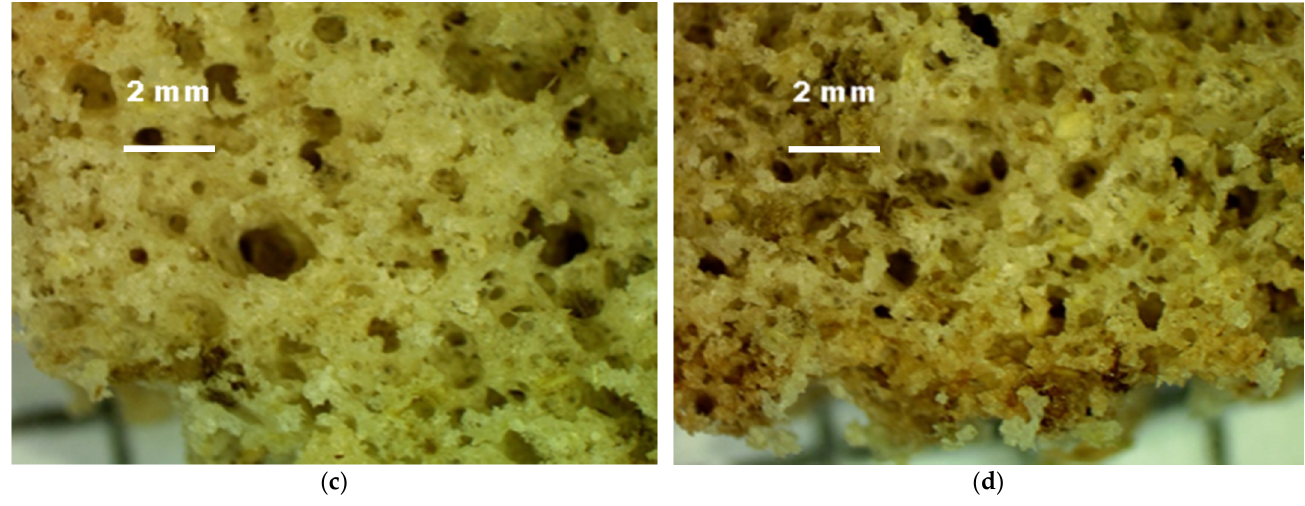
Figure 6. Microscopic images of the Crumb of the sponge cakes. ( a ) Crumb of Control. ( b ) Crumb of Option 1. ( c ) Crumb of Option 2. ( d ) Crumb of Option 3.